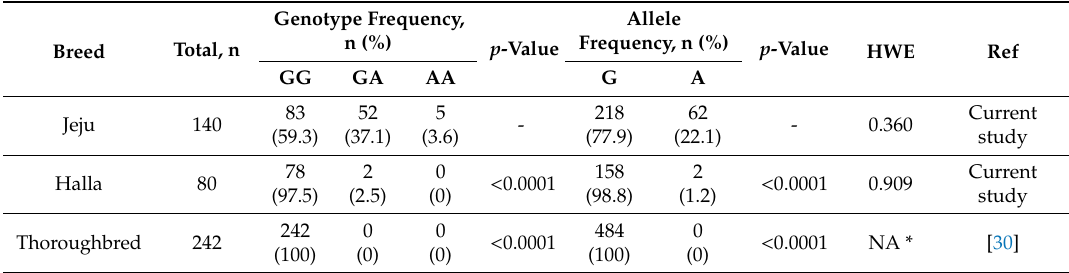
Table 1. Genotype and allele frequencies of the PRND c.331G > A polymorphism in Jeju, Halla, and Thoroughbred horses.